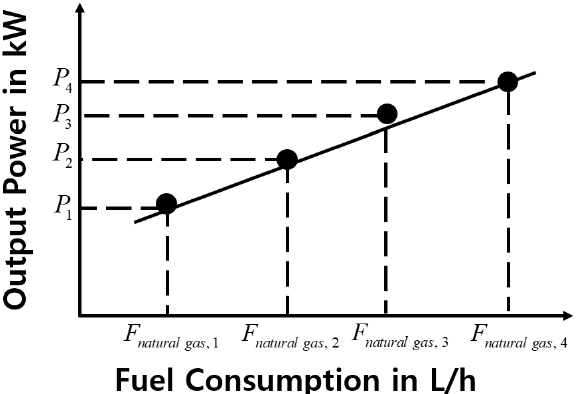
Figure 2. Typical microturbine input and output characteristics.